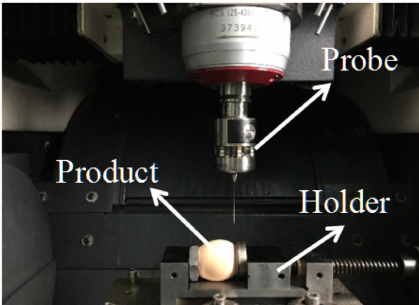
Figure 2. On-machine measurement of the surface profile